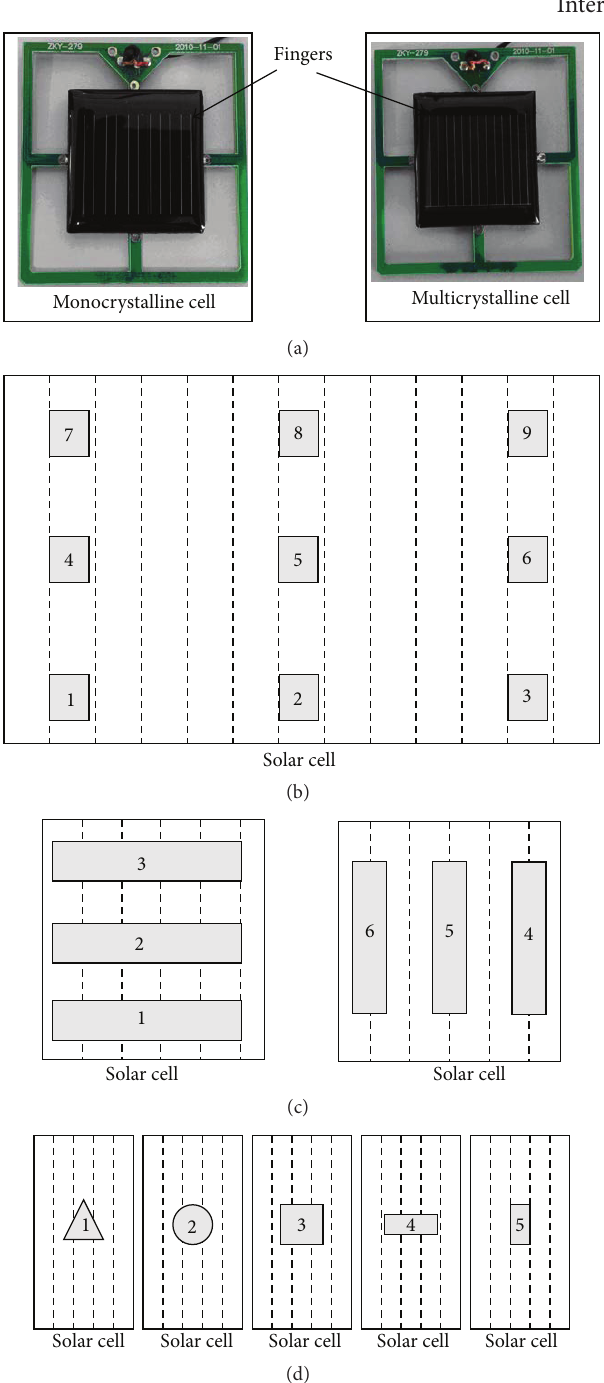
Figure 1: Experimental samples (a), the nine shelter locations by using 1cm × 1cm black square card (b), the six shelter locations by using 2 cm × 1 cm black rectangle card (c), and the center shelters with isosceles triangle, circle, square, and two rectangles black cards whose areas are 2cm 2 (d). The dashed lines are the cell’s fingers (not to scale). of multicrystalline cell. Thirdly, it is noted that the short- circuit current and current at maximum power point of both cells will be decreasing dramatically as a rectangular black shading card with a long side parallel to cell’s finger, compared with that normal to cell’s finger. Finally, it can be seen that the effect of shading on the electrical parameters of both cells will be significantly suppressed when the border lines of shading match the shaded